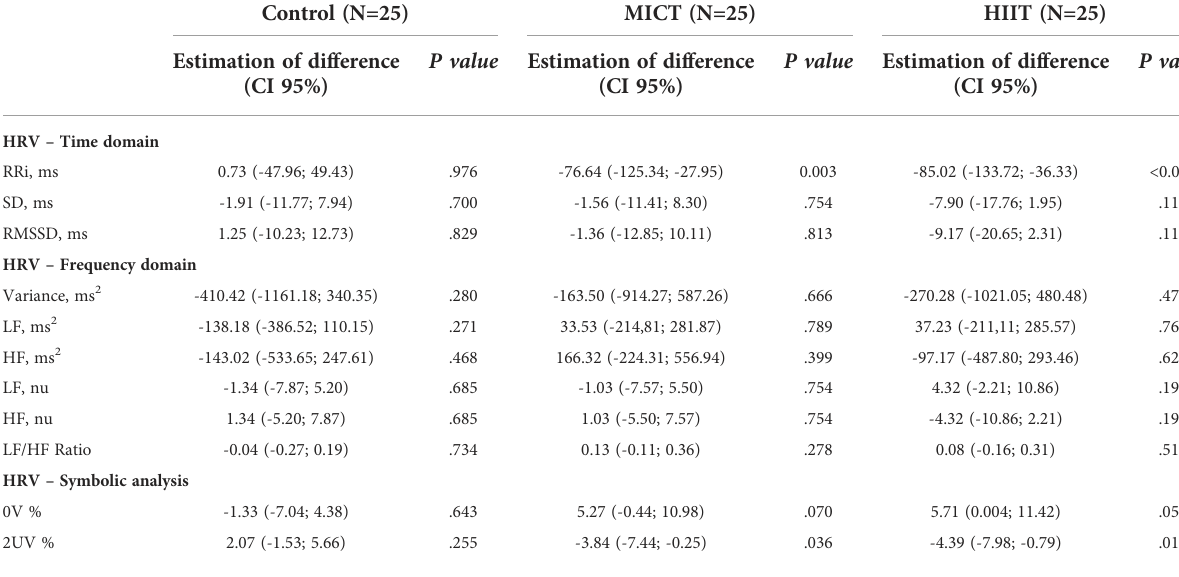
TABLE 5 Intragroup comparison of autonomic parameters obtained before and after the 16-wk of physical